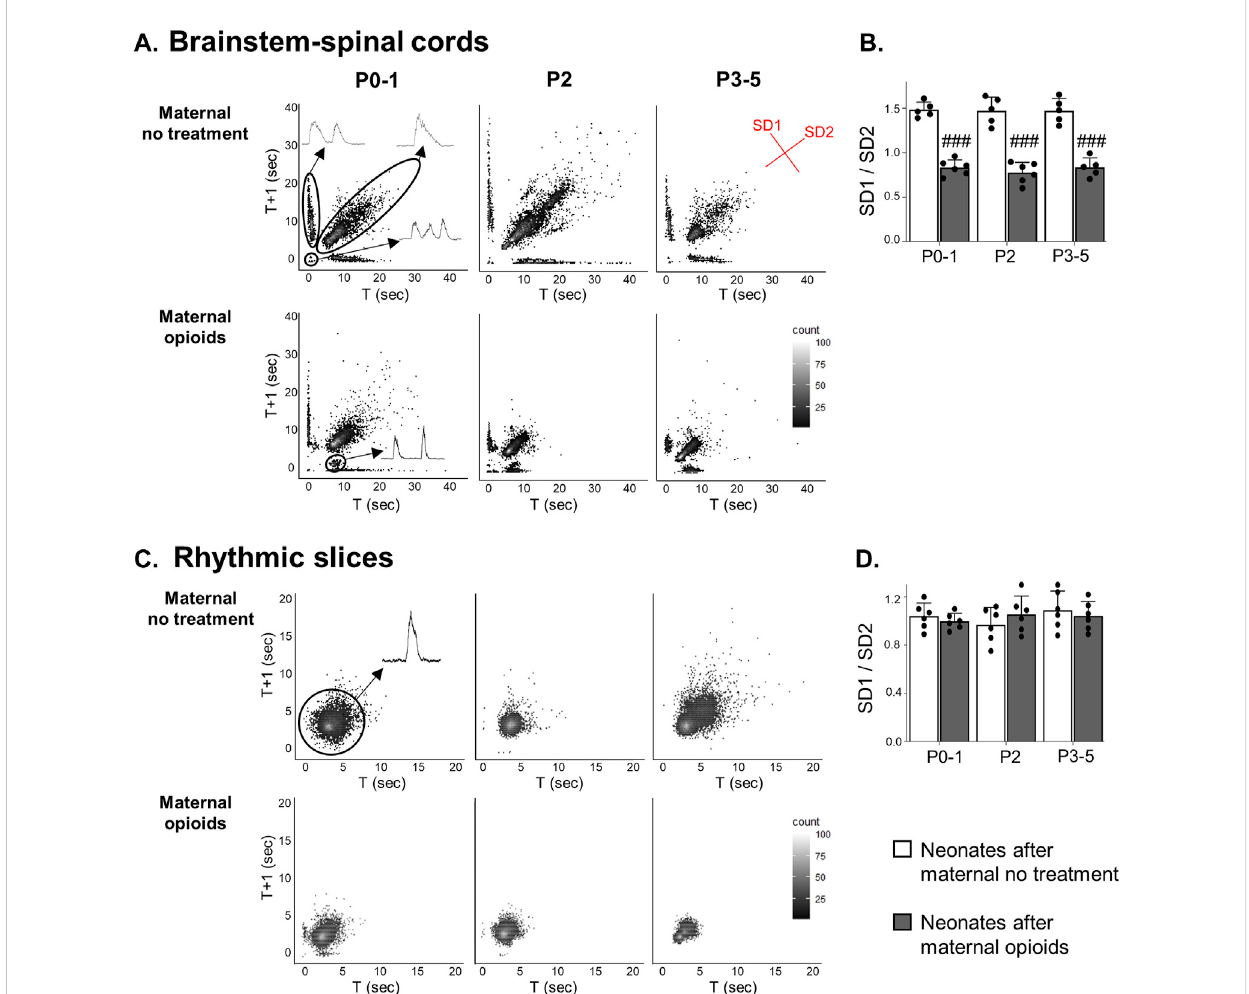
FIGURE 7 Adistinctrespiratorypatternemergedinneonatalisolatedbrainstem-spinalcords, but notrhythmicslices,after maternal opioids.Poincaréplots (A) show burst-to-burst variation in isolated brainstem-spinal cords (BSSCs). Three respiratory burst patterns were prominent after maternal no treatment: singlets, doublets, and triplets (inset). In neonates after maternal opioids, a distinct respiratory burst pattern emerged. SD1/SD2 measurements of burst- to-burst variation in isolated BSSCs (B) decreased in neonates after maternal opioids compared to neonates after maternal no treatment. In rhythmically active slices, singlet burst activity was prominent (inset) in all treatmentgroups and ages (C) and burst-to-burstvariation (D) was unchanged in any treatment group or age ( ### p < 0.0001 different from neonates maternal no treatment at all ages; Two-way ANOVA; Bonferroni post-hoc